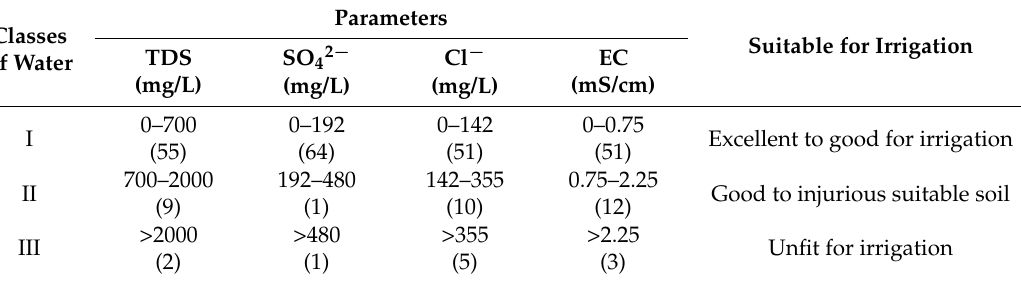
Table 6. Suitable of water with different constituents for irrigation.